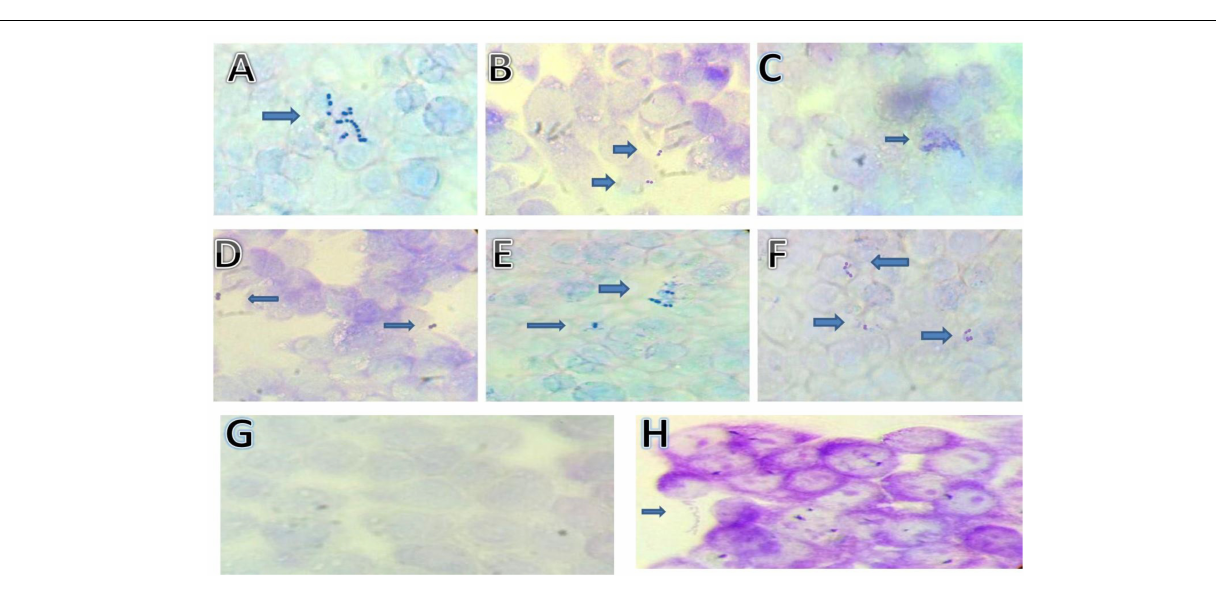
FIGURE 3 | Adhesion of S. thermophilus cells on HT-29 cell cultures observed under light microscope (100 × ). Strains: (A) S. thermophilus MTH17CL396, (B) S. thermophilus M17PTZA496, (C) S. thermophilus TH982, (D) S. thermophilus TH985, (E) S. thermophilus TH1435, (F) S. thermophilus TH1436, (G) Blank HT-29 cell line, (H) Lb. rhamnosus